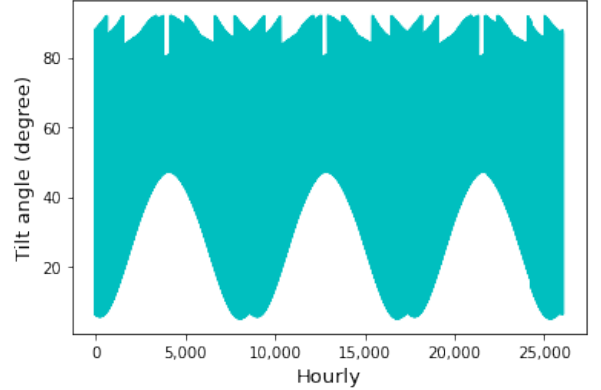
Figure 7. Visualisation of tilt angles recorded hourly from 1 January 2017 to 31 December